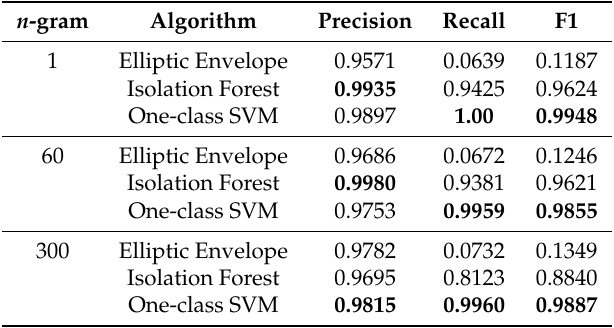
Comparison of Elliptic Envelope, Isolation Forest and one-class SVM algorithms. Best performance is highlighted in